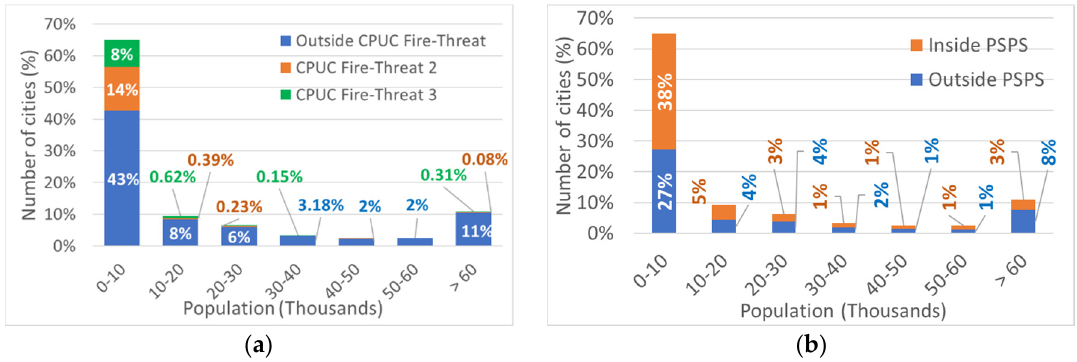
Figure 4. Proportion of cities in California classified by population overlapping with ( a ) CPUC Fire-Threat areas and ( b ) PSPS by Pacific Gas and Electric Company (PG&E) and Southern California Edison (SCE).